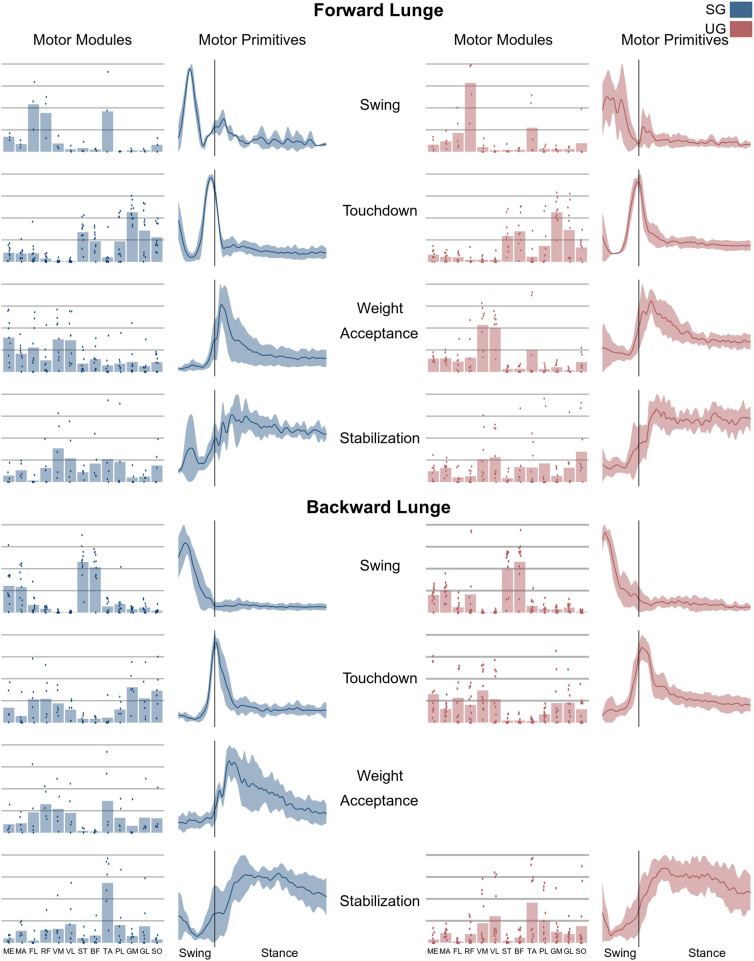
Average motor modules and motor primitives of the fundamental synergies needed to perform the forward and backward lunges on stable and unstable ground condition. The motor modules are presented on a normalized y-axis base: each muscle contribution within one synergy can range from 0 to 1 and each point represents an individual trial. Motor primitives mean and standard deviation bands are presented for one trial (from lift-off to steady-state), time-normalized to 200 points (x-axis), and amplitude-normalized to maximum (y-axis). The vertical line in the primitive panels indicates the touchdown (i.e., the beginning of the double leg stance).